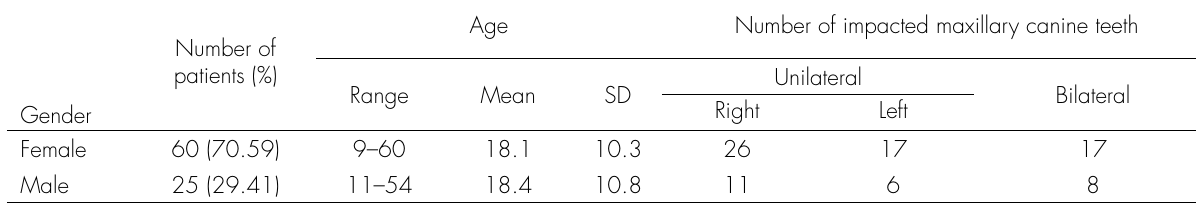
Table I. Descriptive data regarding gender, age, and distribution of impacted maxillary canine teeth.